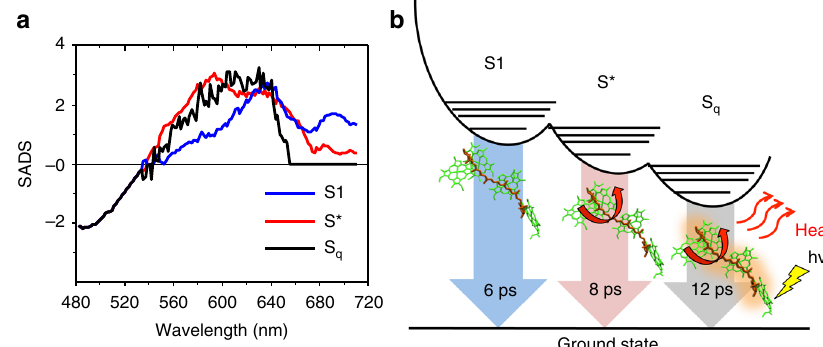
Fig. 4 Dark states of astaxanthin bound to LHC – Asta. a Overlay of the SADS of the different Car dark states estimated from the target analysis reported in Fig. 3. b Simpli fi ed scheme of the potential energy surface of astaxanthin bound to LHC – Asta. In this representation, S1 is higher in energy than S* and S q , in accordance with previously published information 41 . S q is positioned at the lowest level because it is found to be the only state able to quench Chls in LHC – Asta. For further explanation, see text. The red arrows indicate that S q , similarly to S* 41, 68 , originates from twisted conformations of the Car